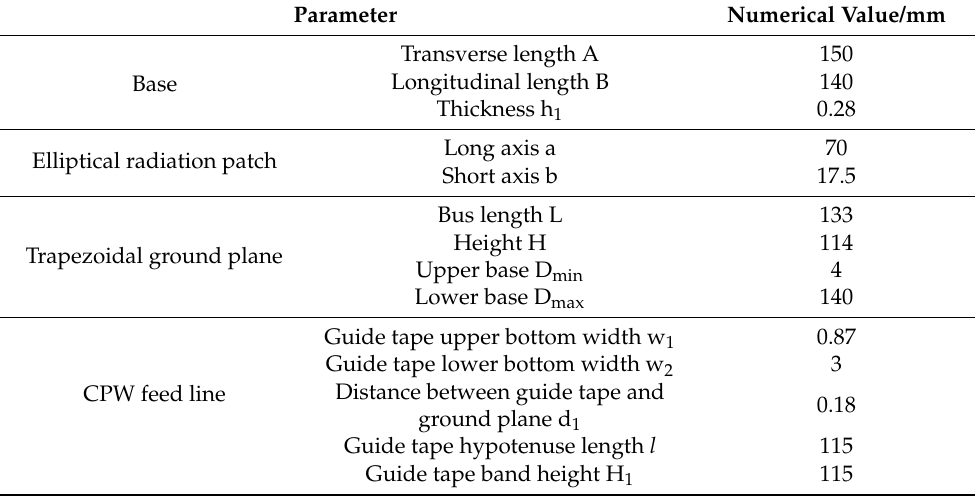
Table 1. Design parameters of Antenna.